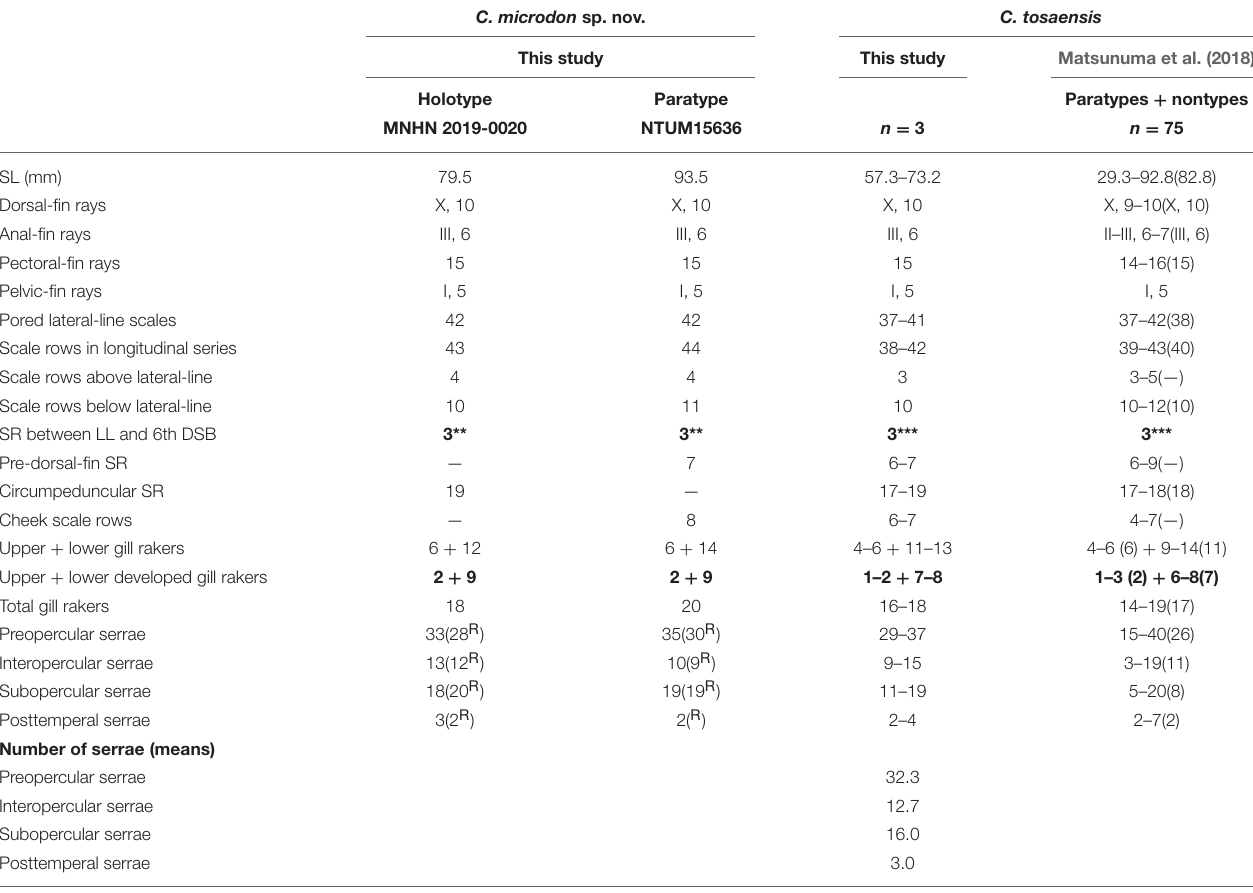
TABLE 2 | Meristic features of Chelidoperca microdon sp. nov. and C. tosaensis (including examined specimens and reference data); bold font presents distinguishing characteristics; parentheses in Matsunuma et al. (2018) contains holotype